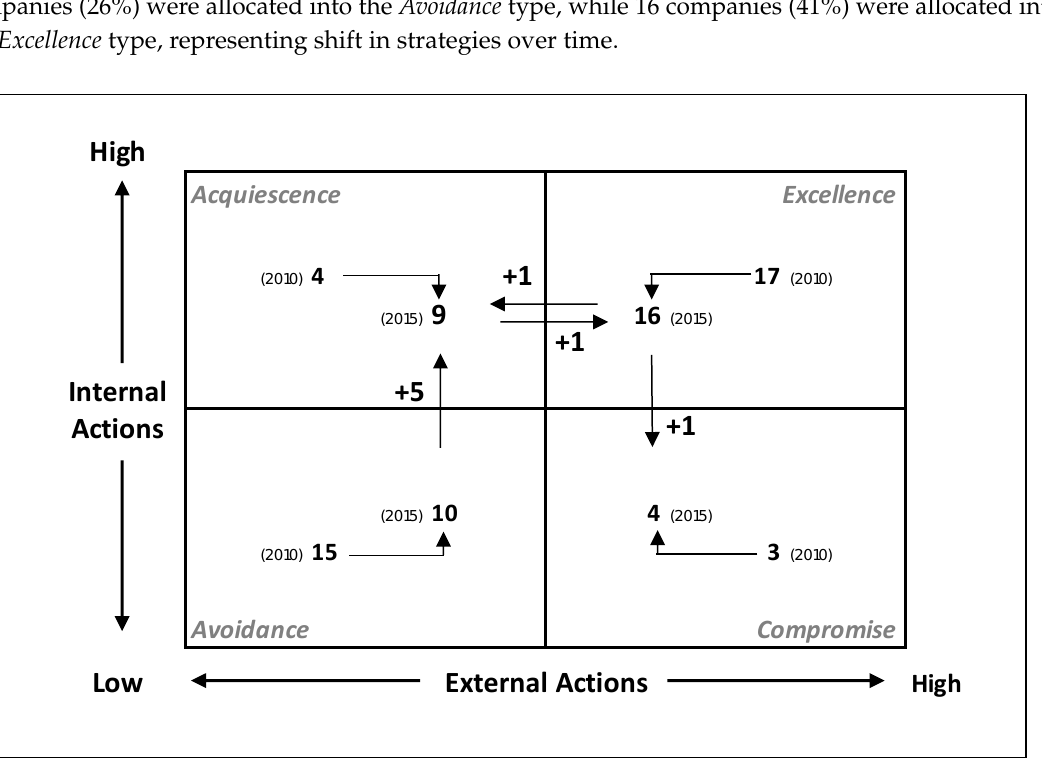
Figure 2. Summary of the shifts in carbon disclosure strategies.